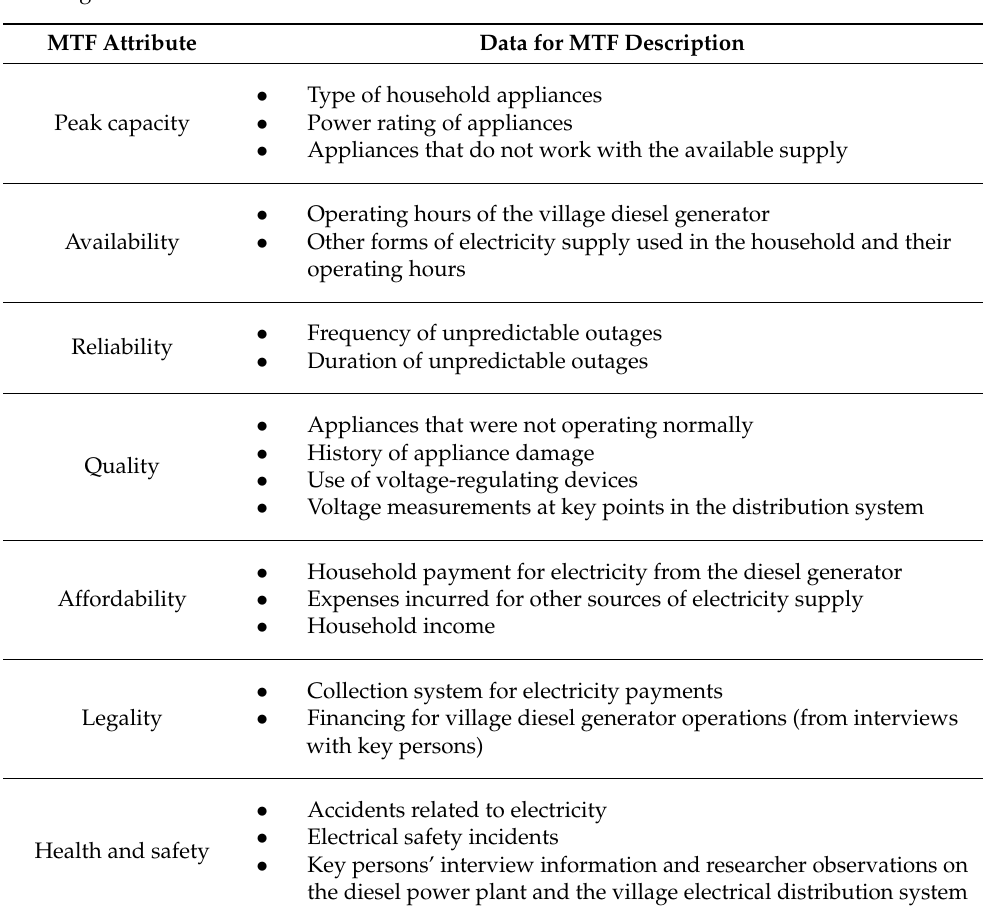
Table 2. Data that are needed for creating MTF descriptions of household electricity access on Gilutongan